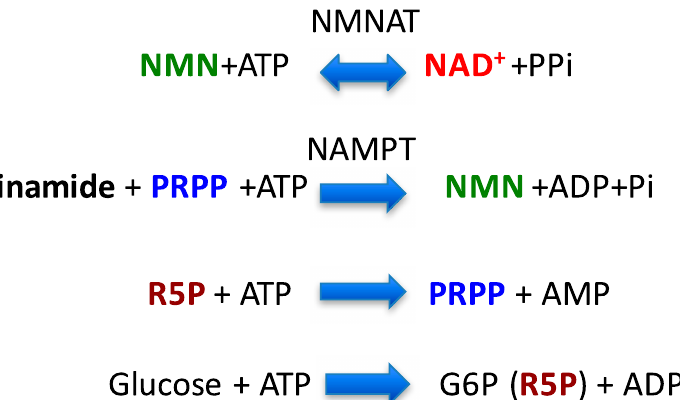
Figure 2. Enzymatic cascade that synthesizes NAD+ from nicotinamide. Nicotinamide can be salvaged to NAD + by consuming several ATPs.